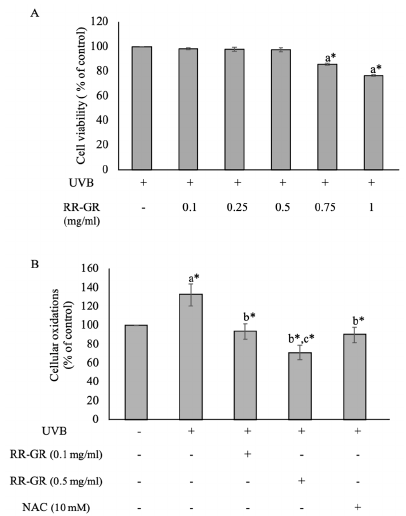
Figure 4. Cell viability was observed under MTT assay ( A ). Cellular oxidant was determined by the DCFH-DA method ( B ). N-acetylcysteine (NAC) was used as a positive control. The statistical sig- nificance of differences in each group was calculated by mean ± SD with the control (100%). a repre- sents statistical significance compared with control. b represents statistical significance between ra- diated and treated cells. c represents statistical significance between treated cells. * Statistical signif- icance at 𝑝 ≤ 0.001.